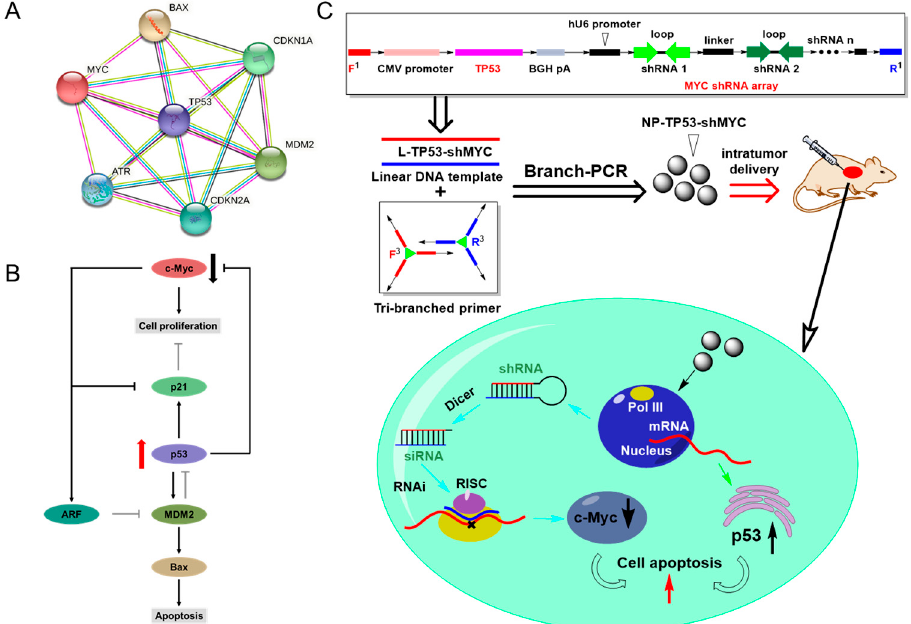
Figure 1. The network-based multiplex gene regulation of TP53 and MYC for genome therapy using a branch-PCR-assembled nanovector. ( A ) An illustration of the gene network of cell proliferation and apoptosis. The interactive relationship of different proteins was constructed from the STRING database. ( B ) The dual targeting of hub genes for the network regulation of cell proliferation and apoptosis. ( C ) An illustration of the branch-PCR-assembled gene nanovector for genome therapy. A tri-branched primer pair (F 3 and R 3 ) was used to construct NP-TP53-shMYC nanovectors containing TP53 expression elements and MYC shRNA transcription elements. The nanovector could penetrate tumor cells to transcribe TP53 mRNA and the MYC shRNA array. TP53 mRNA was then translated into the p53 protein, and the MYC shRNA array was processed by Dicer into siRNAs to mediate the knockdown of MYC mRNA. The overexpression of p53 proteins and the elimination of c-Myc proteins suppressed tumor overgrowth.